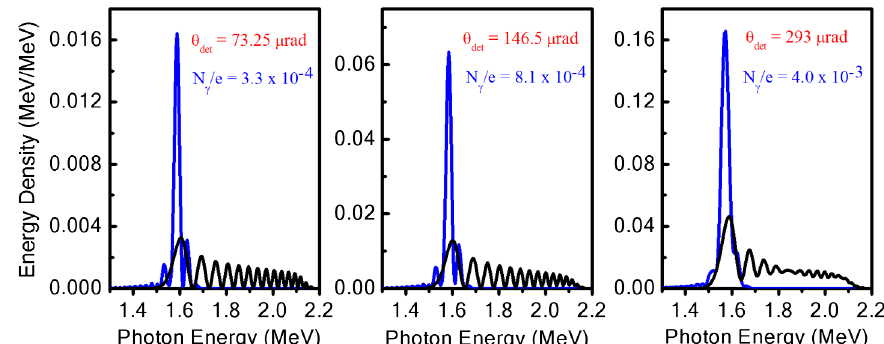
FIG. 8. Energy density integrated over a finite detector size from the scattering of a 300-MeV electron by a 90-fs FWHM and 1 : 6 (cid:3) 10 18 - W = cm 2 -peak-intensity chirped laser pulse (blue line) and transform-limited pulse (solid black line). The energy density is calculated for three different detectors subtending a collection cone with half angles: (cid:4) det ¼ 73 : 25 (cid:3) rad (left panel), 146 : 5 (cid:3) rad (center panel), and (cid:4) 293 (cid:3) rad (right panel). The number of photons per electron ( N (cid:4) det ¼ det ¼ detector for the chirped laser pulse (blue line) is shown in the figure.